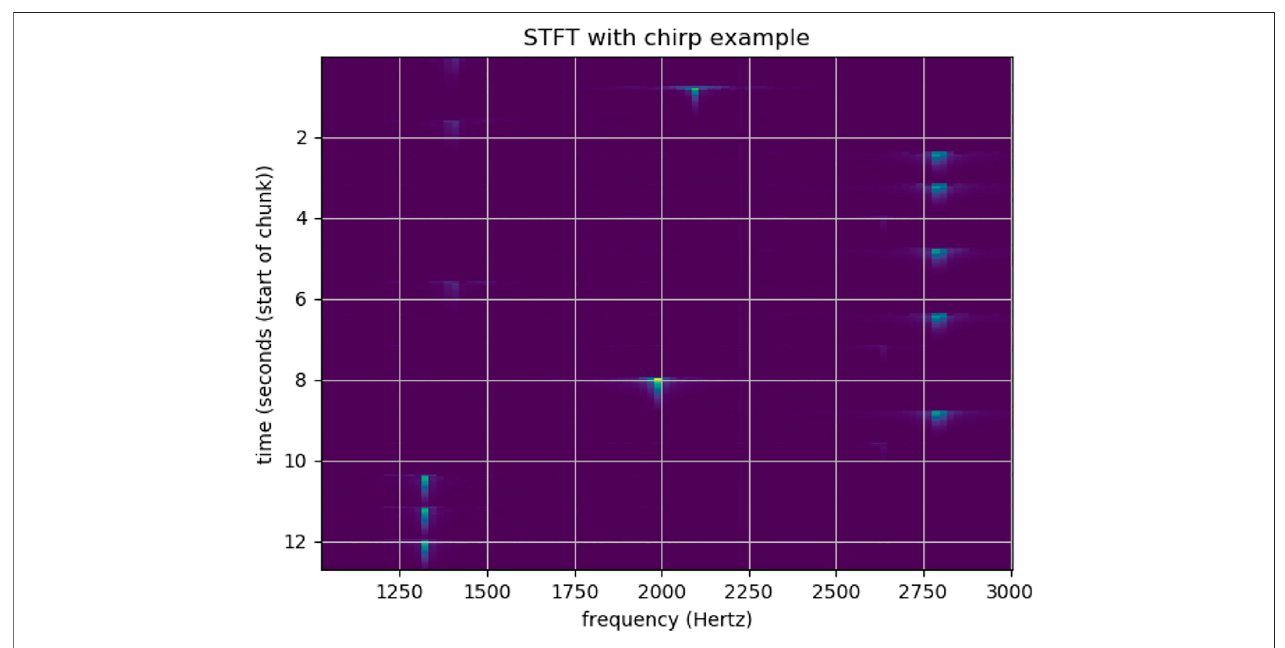
FIGURE 8 | Melody detection with Short Time Fourier